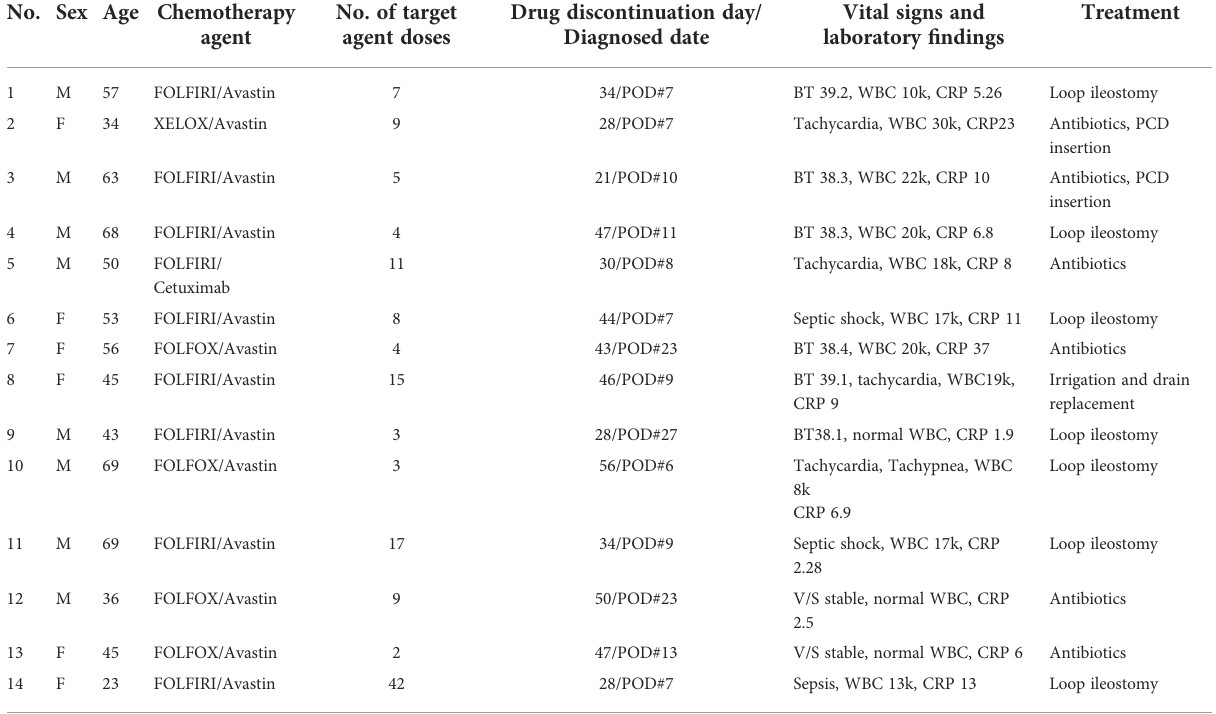
TABLE 3 Detailed information and treatment of patients diagnosed with anastomosis site